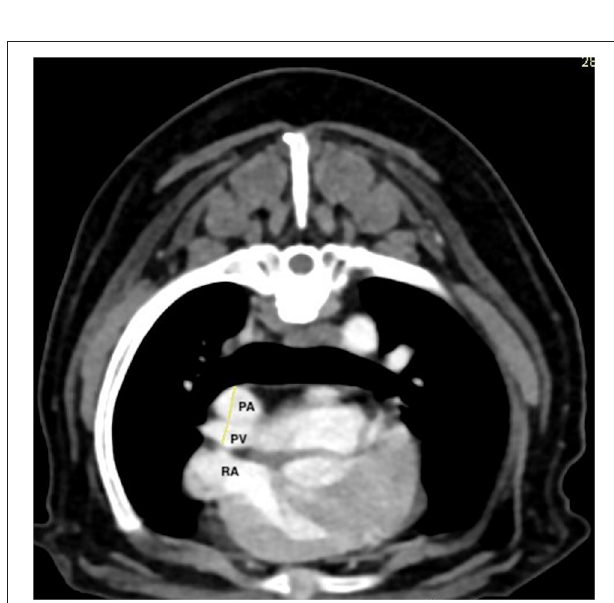
FIGURE 3 | Post-contrast transverse thoracic computed tomographic angiography (CTA) at the level of the right atrium (RA). The right pulmonary artery (PA) and its adjacent pulmonary vein (PV) were measured dorsal to the right atrium. The pulmonary artery is dorsal and the vein ventral.